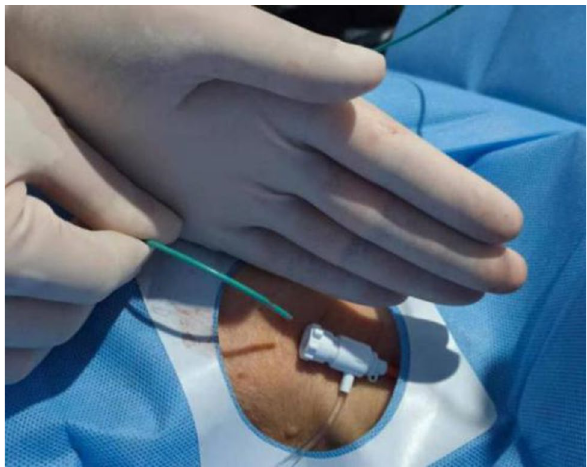
Figure 2. Forming an angle of 30° between the electrode and the sagittal